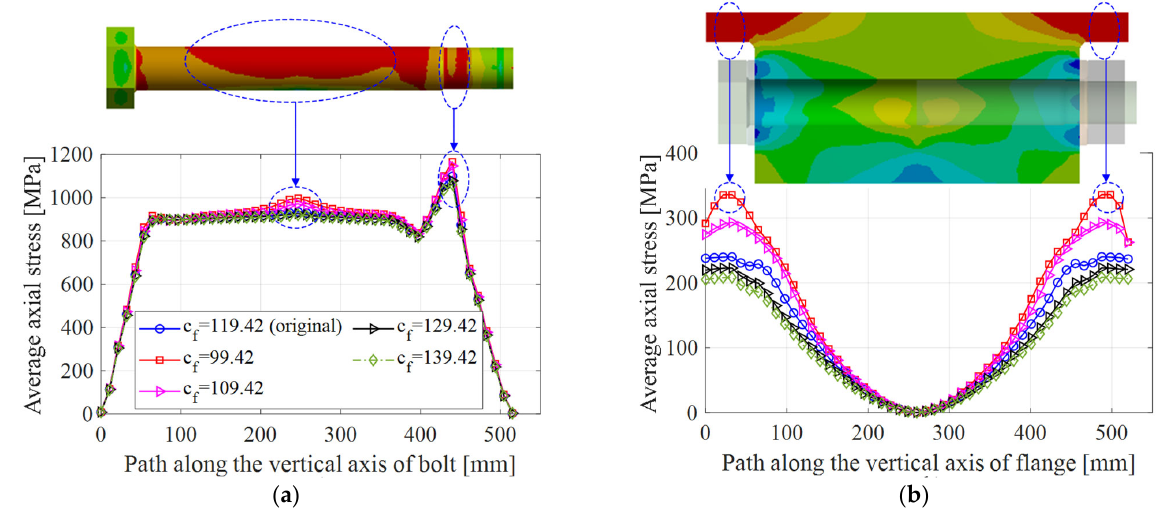
Figure 11. Influence of flange width on stress distributions: ( a ) bolt and ( b ) flange.